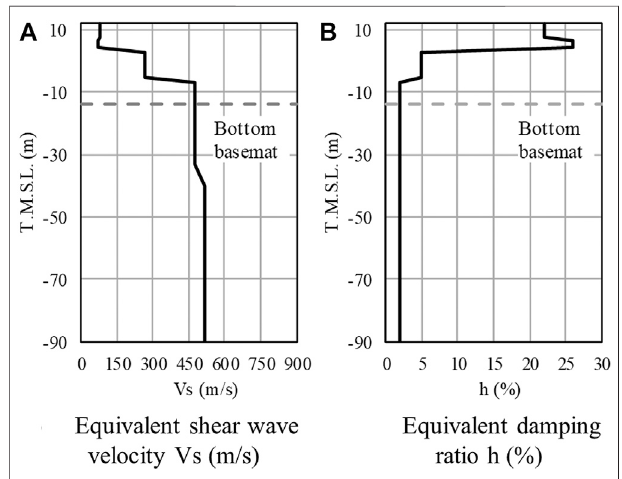
FIGURE 6 | Distribution of equivalent shear wave velocity and damping